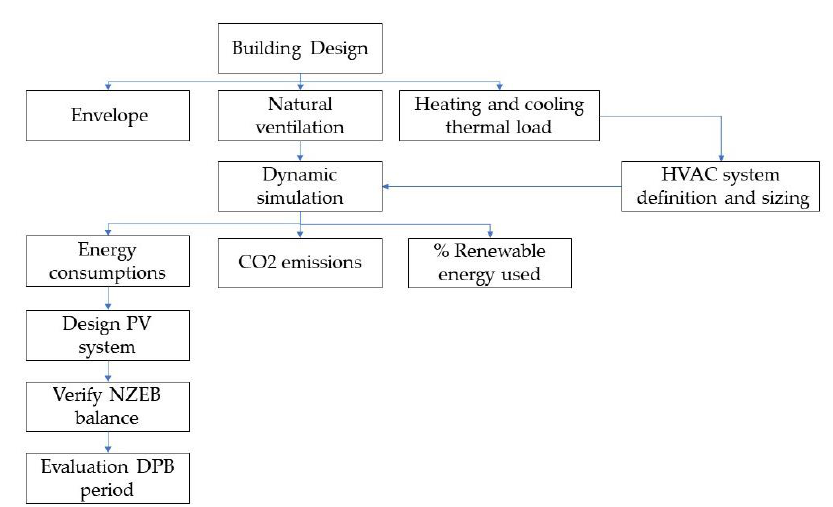
Figure 1. Design and computational workflow followed for obtaining the Net Zero Energy Building (NZEB) target.